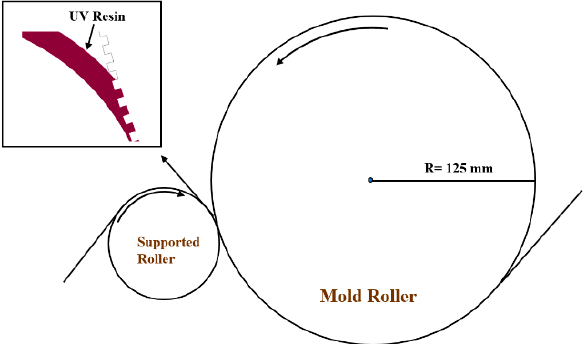
Figure 2. Schematic diagram of imprinting module and UV resin contact with the roller mold in the magnified view.